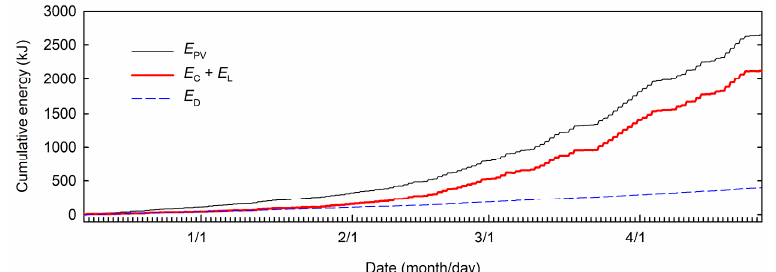
Figure 13. Energy balance of the PV blind system during the five-month operation test: E PV , E C + E L , and E D represent the cumulative PV generated energy, surplus energy, and drive-circuit supplied energy, respectively. Table 3. Energy balance of the PV blind system at the end of five-month operation test.